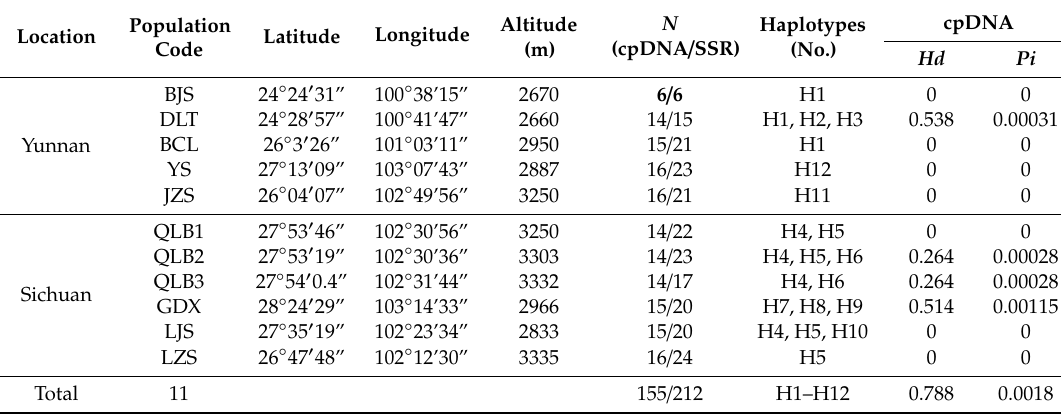
Figure 1. Distribution of chloroplast DNA (cpDNA) haplotypes ( A ); map of the geographic distribution of nuclear microsatellite clusters when the assumed cluster numbers are ( B ) K = 3 and ( C ) K = 6 in 11 populations of Rhododendron rex subsp. rex . Table 1. Details of sample locations, sample size ( N ), haplotype diversity ( Hd ), and nucleotide diversity (Pi) surveyed for cpDNA sequences of R. rex subsp. rex. SSR—microsatellite